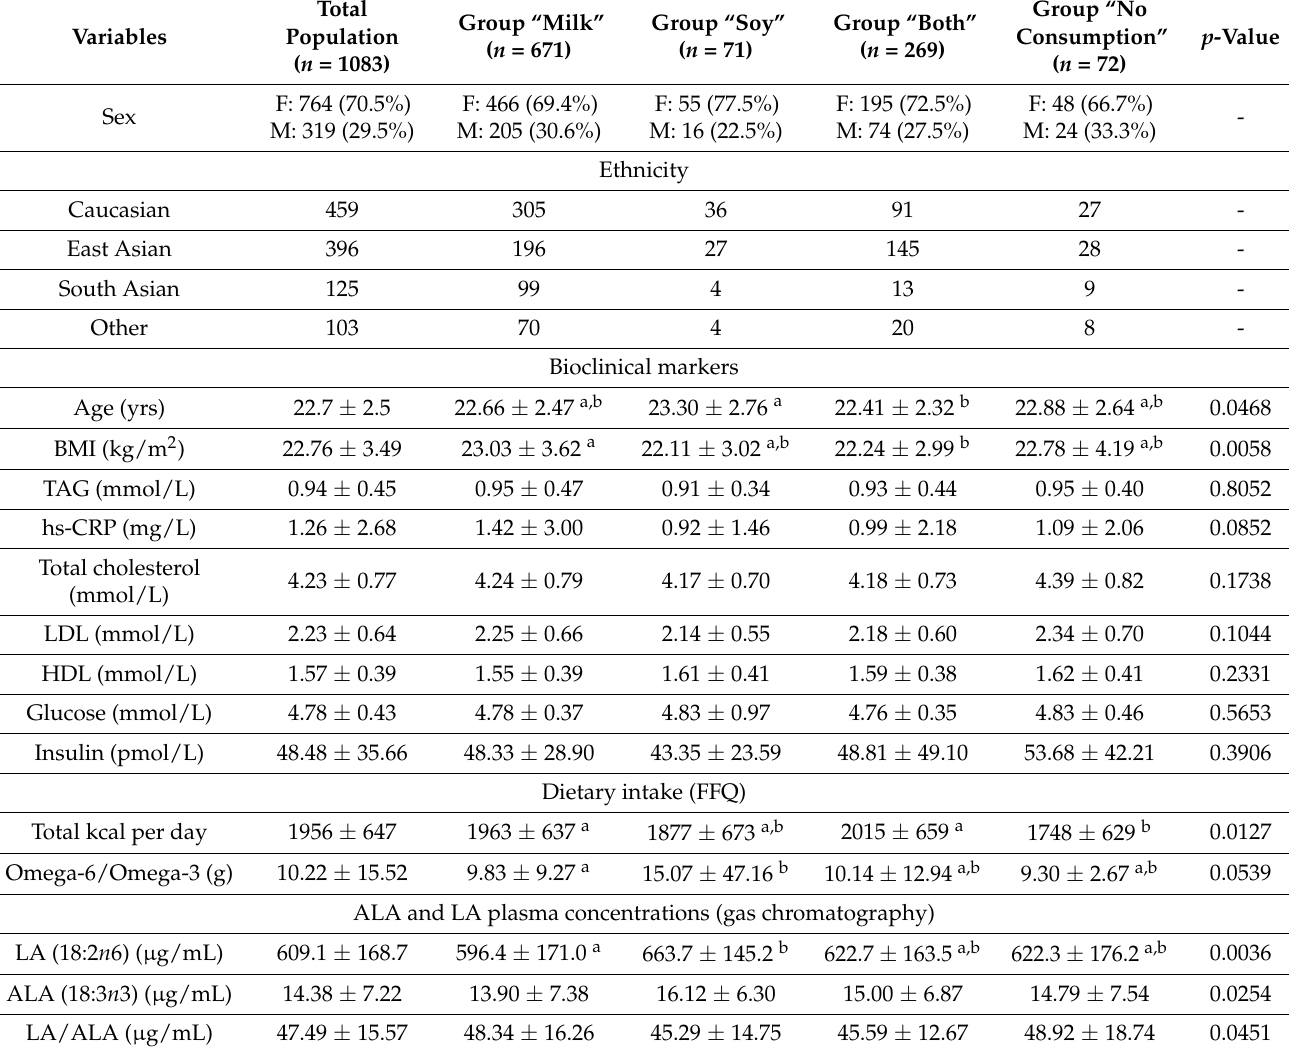
Table 1. General characteristics of the population by beverage intake subgroups 1,2